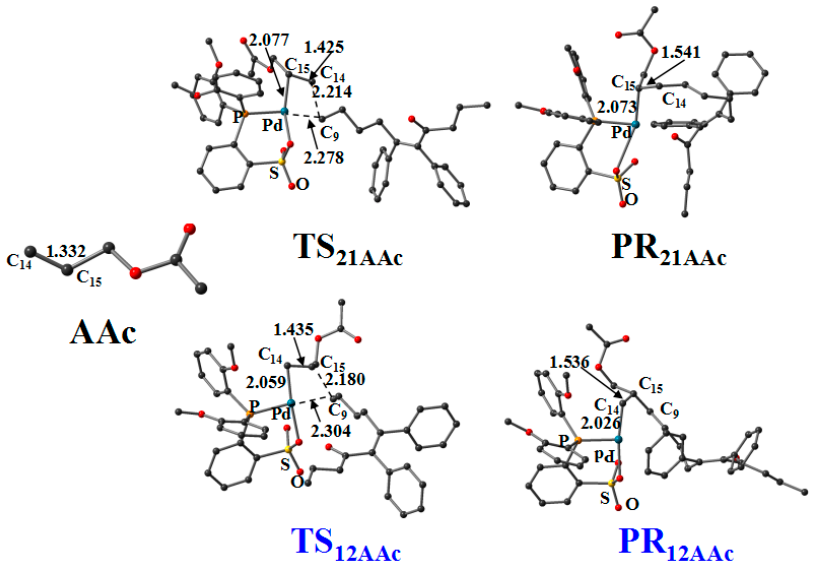
Figure 12. Optimized structures in the allyl acetate (AAc) insertion reaction pathway shown in Figure 11, Path A AAc (black) and Path B AAc (blue), the key length is in angstroms. For clarity, the hydrogen atom is omitted. Table 5. The Wiberg bond indices (WBIs) and natural charges (Q NBO ) for some key bonds and atoms of the reaction pathway of the allyl acetate (AAc) insertion.